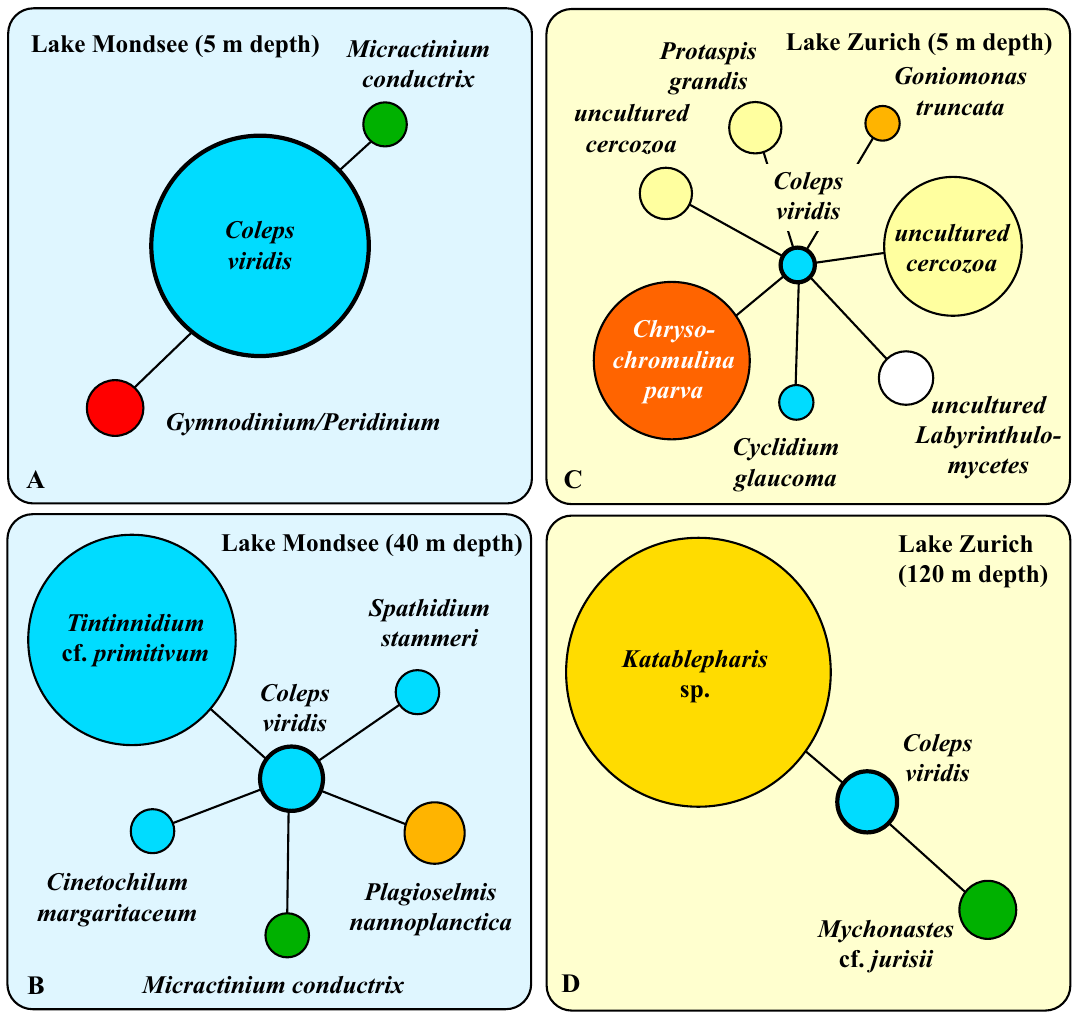
Figure 9. Co-occurence network of Coleps viridis in both lakes at two depths ( A , B Lake Mondsee, Austria at 5 m and 40 m depths, respectively; C , D Lake Zurich, Switzerland at 5 m and 120 m depths, respectively) based on HTS approach using the V9 region of the